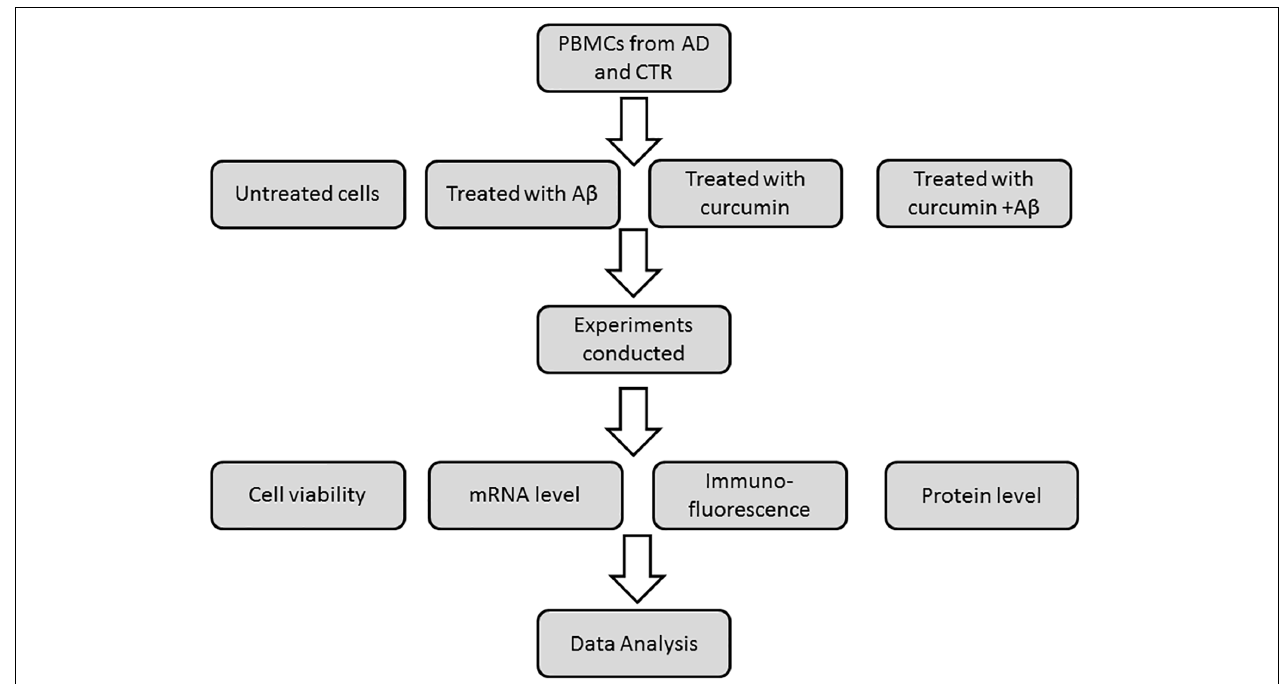
FIGURE 2 | Schematic representation of experimental plan.